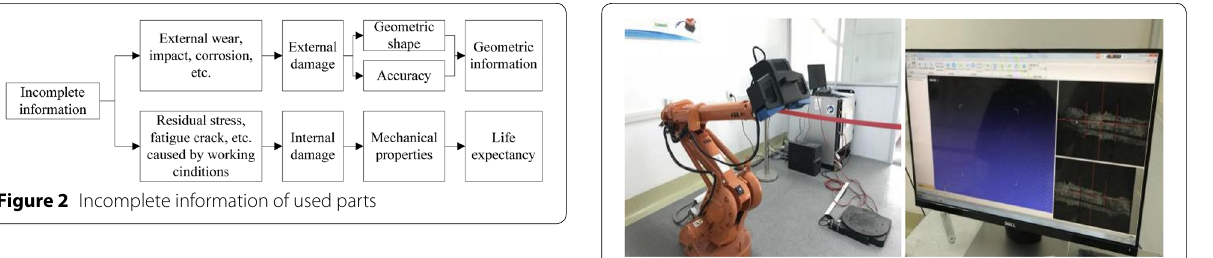
Figure 3 Data acquisition equipment and